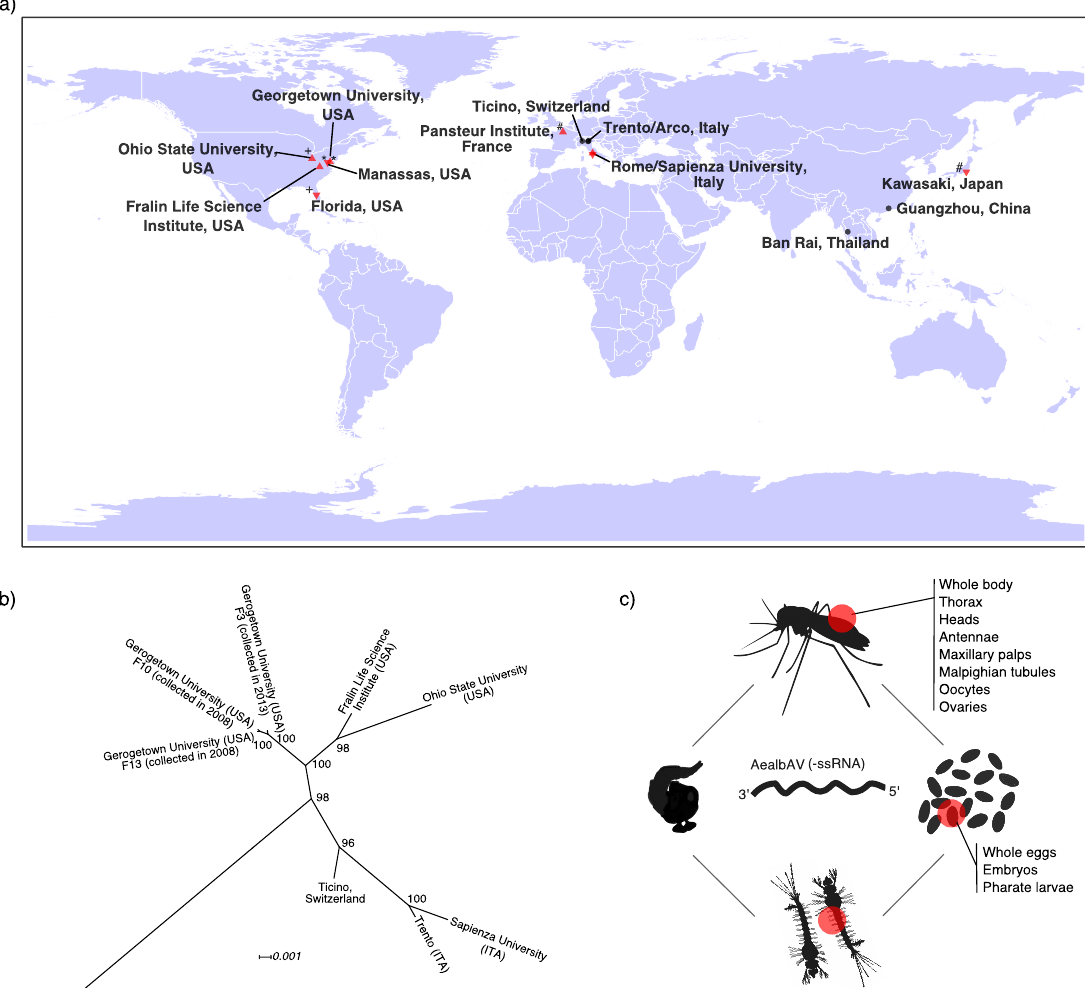
Figure 3. Geographical and tissue distribution of AealbAV and phylogenetic relationship of AealbAV strains. ( a ) AealbAV is present worldwide in Ae. albopictus laboratory colonies and wild-caught mosquitoes. Locations of mosquito collection from RNA-Seq and miRNA-Seq libraries that harbor AealbAV are shown. Red up-pointing triangles refer to the location of the laboratory colonies; Red down-pointing triangles refer to the collection sites of the samples used to establish the laboratory colonies (if this information was available). An identical symbol nearby the triangles specifies the link between collection and colony sites (also see Table 1); Black points refer to the collection sites of wild-caught mosquitoes. ( b ) Phylogeny of representatives AealbAV genomes from di ff erent geographical locations. AealbAV genomes cluster by the geographical origin of their mosquito hosts. AealbAV strain from Thailand is the most di ff erentiated. The unrooted Maximum likelihood phylogeny was constructed from alignments of nucleotide sequences of AealbAV strains using a GTR + F + I model with 1000 bootstraps. Node values correspond to bootstrap support. Branch lengths represent expected numbers of substitutions per nucleotide site. ( c ) AealbAV sequences were found in Ae. albopictus libraries derived from various life stages including embryos / eggs, and tissues, including oocytes and